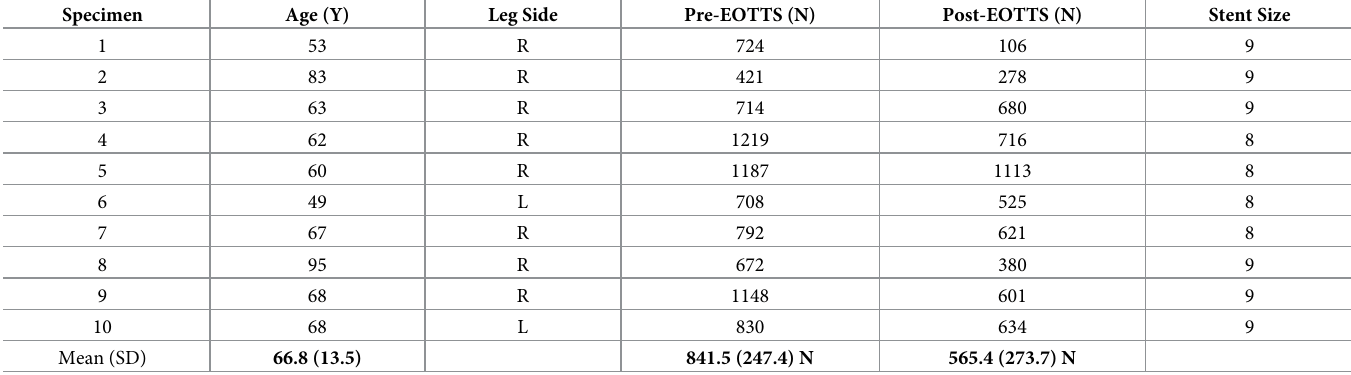
Table 1. Comparison of medial compartmental compressive forces. Where Y = years, R = right limb, L = left limb, EOTTS = extra-osseous talotarsal joint stabilization, N = Newtons, SD = standard